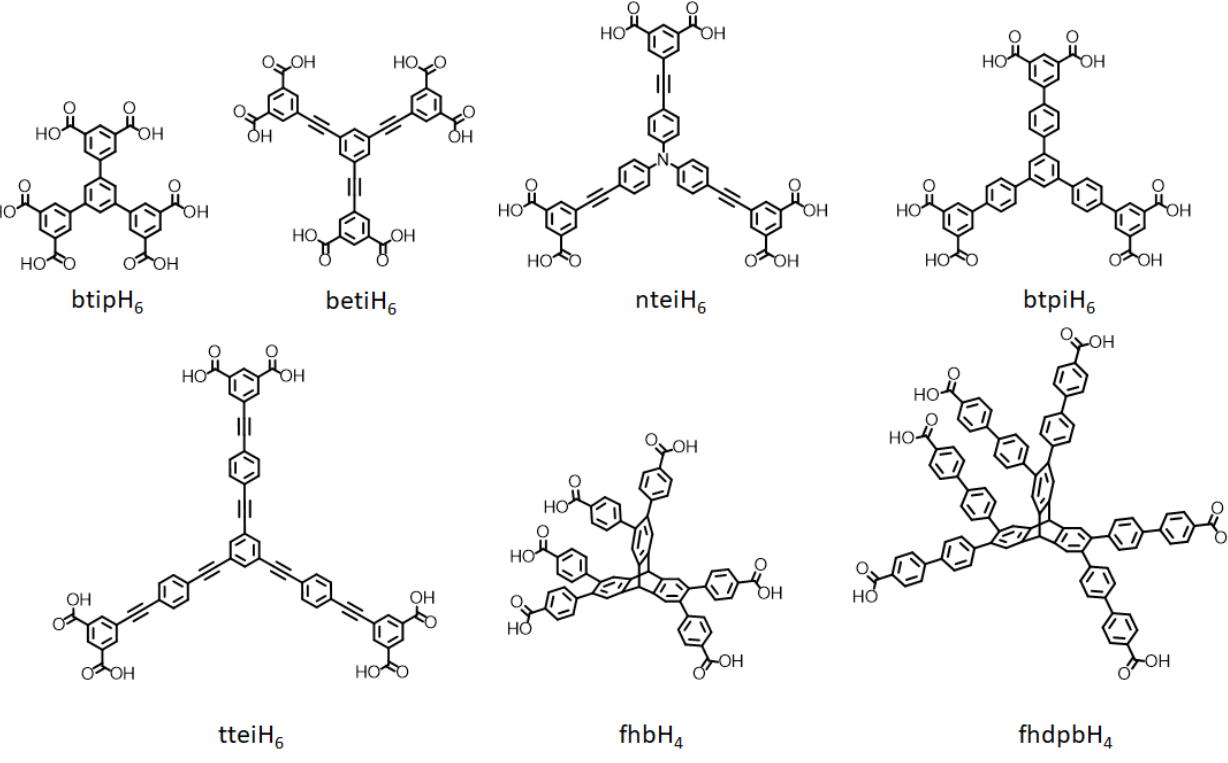
Scheme 3. Polytopic linkers used in the synthesis of HPMOFs.